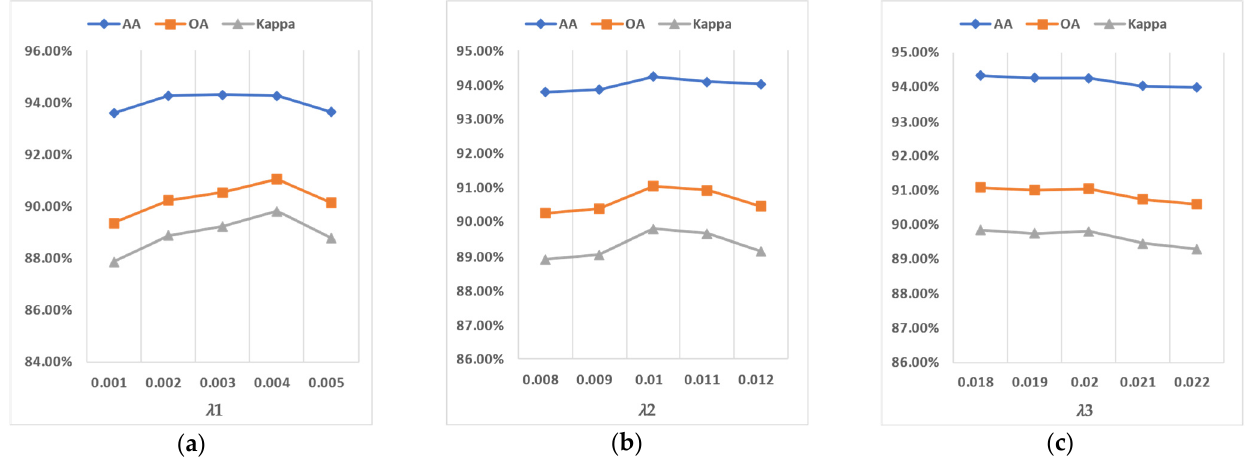
Figure 8. Analysis of the sensitivity of different λ in the first stage based on Indian Pines datasets. We selected five representative values at the three smoothing degrees, with an interval of 0.001. ( a ) λ 1 ranges from 0.001 to 0.005; ( b ) λ 2 ranges from 0.008 to 0.012; ( c ) λ 3 ranges from 0.018 to